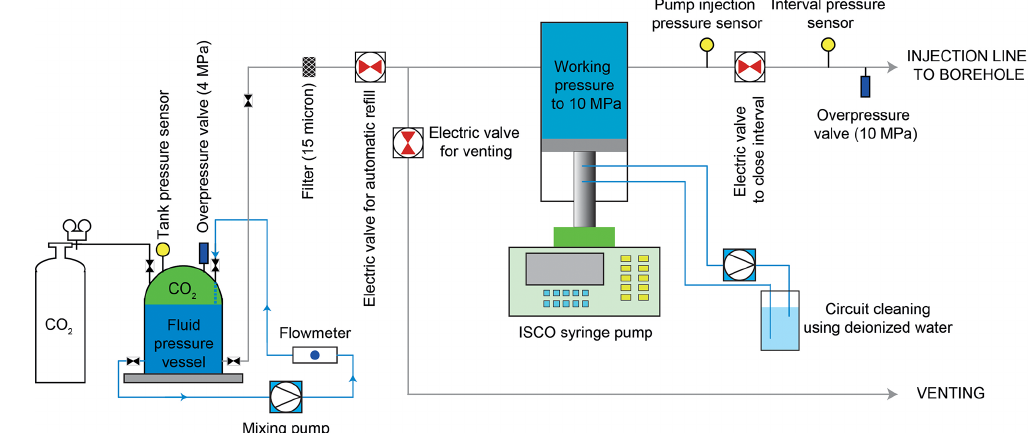
Figure 6. Injection system design for the CS-D experiment (modified after Solexperts AG, Switzerland).